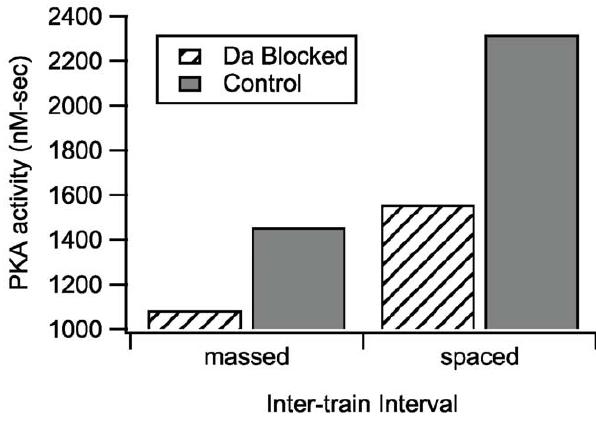
Figure 4. Simulations were repeated with the dopamine receptor blocked, to evaluate the contribution of dopamine to L-LTP. Cumulative PKA activity is reduced significantly with both massed and spaced stimulation intervals. The PKA activity with spaced stimulation and dopamine blocked is comparable to PKA activity with massed stimulation and dopamine unblocked. The reduction in PKA activity for the massed stimulation case is not functionally significant because PKA is not needed for L-LTP produced by massed